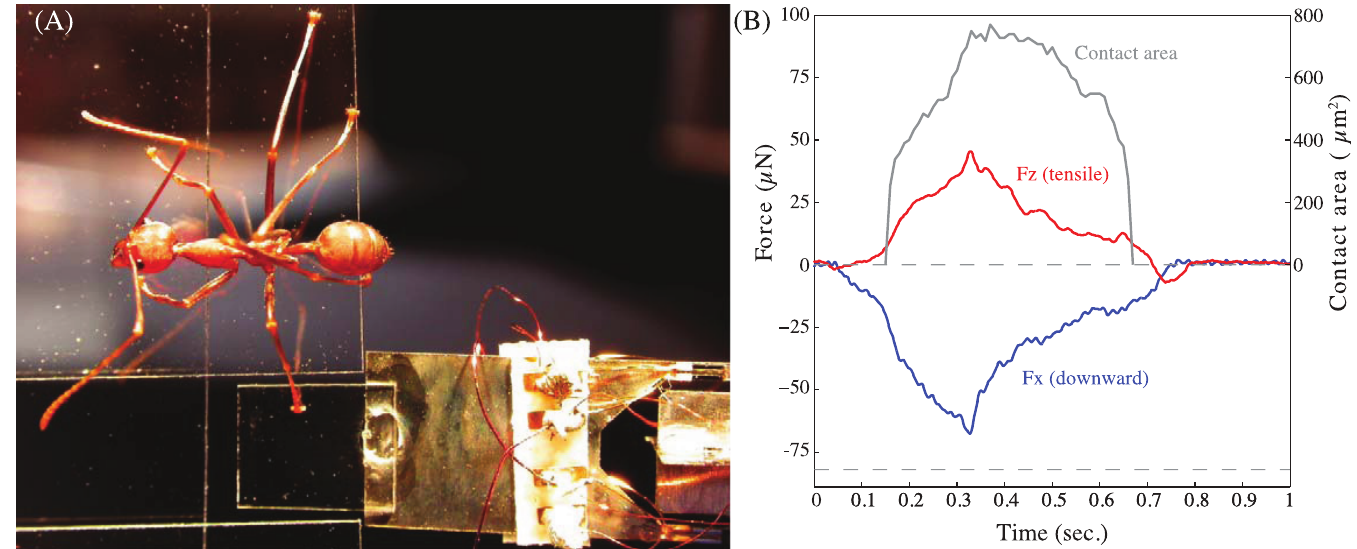
Fig 1. Set-up for ground reaction force recordings. (A) Weaver ants climbing on a vertical surface stepped onto a small, transparent glass plate attached to a sensitive force transducer. (B) Forces in the normal (Z) and vertical (X) directions, and contact area of the arolium for the step of a front leg above the CoM.